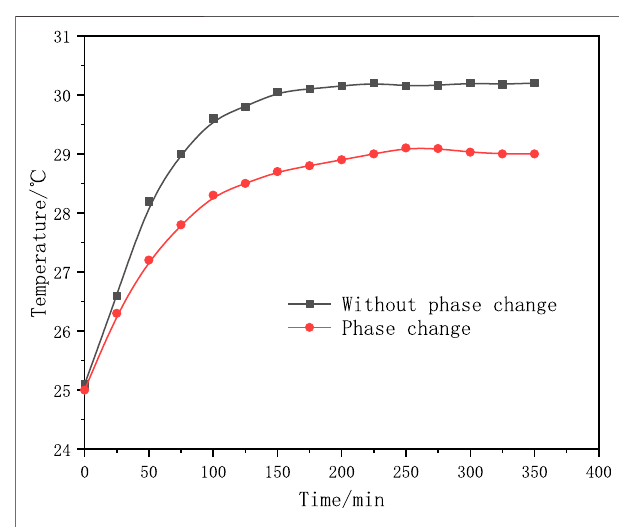
FIGURE 12 | Temperature change curves of internal south wall of the building model with and without phase change.